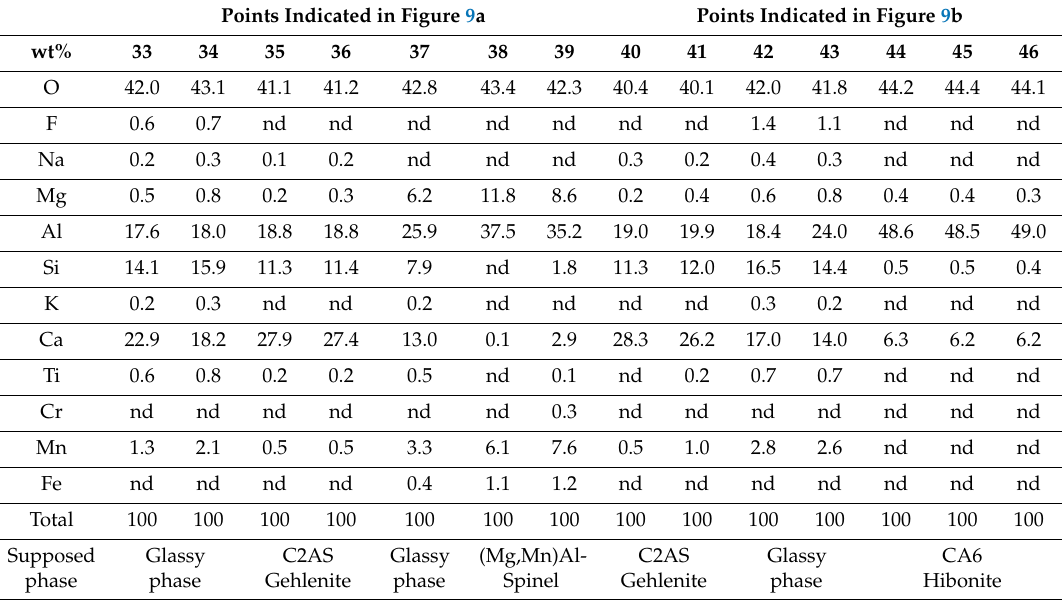
Figure 9. Zoom into Areas a ( a ) and b ( b ) of Figure 8 with the positions of EDX-spot analyses. Table 5. EDX analyses of the points shown in Figure 9a,b. Points Indicated in Figure 9a Points Indicated in Figure